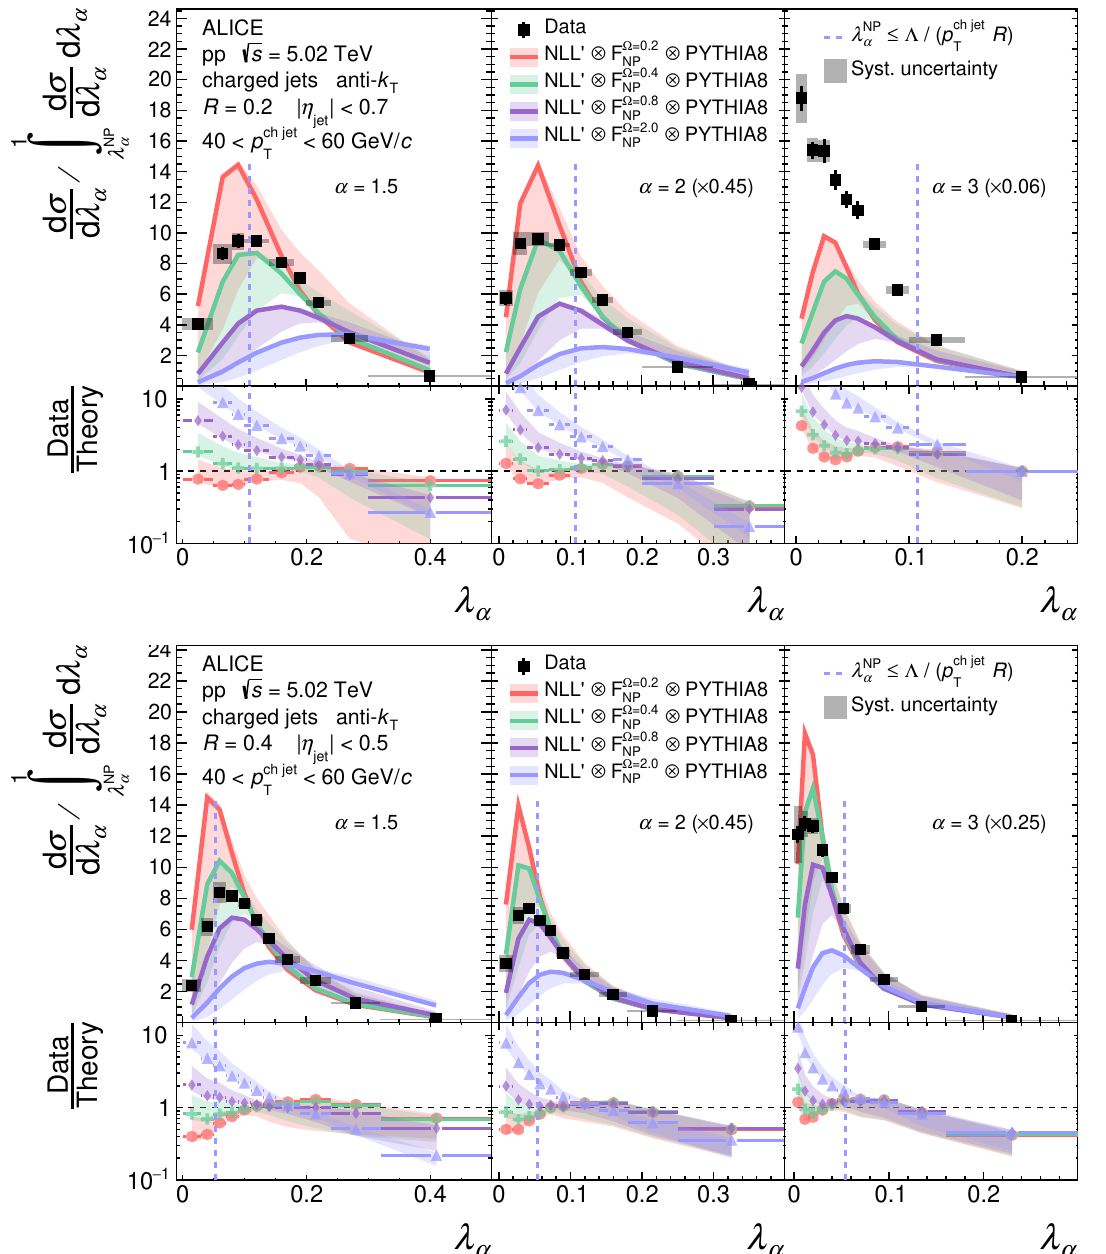
Figure 11 . Comparison of ungroomed jet angularities λ α in pp collisions for R = 0 . 2 (top) and R = 0 . 4 (bottom) to analytical NLL 0 predictions using F ( k ) convolution in the range 40 < p ch jet GeV /c . The distributions are normalized such that the integral of the perturbative region defined by λ α > λ NP (to the right of the dashed vertical line) is unity. Divided bins are placed into the left α (NP)